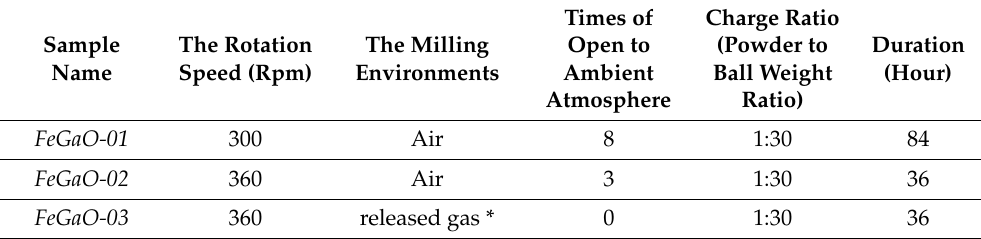
Table 1. The mechanochemical parameters during the synthesis of the